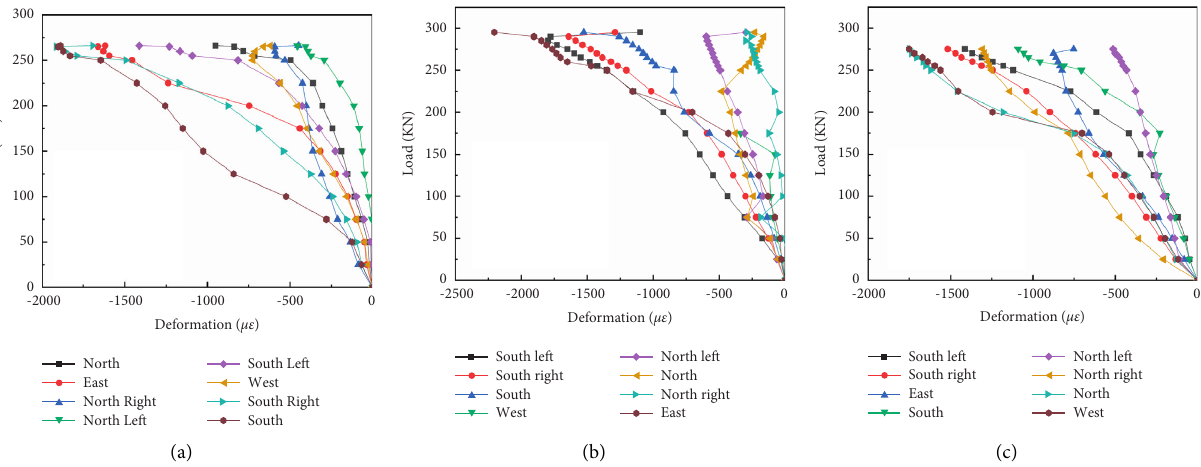
Figure 39: 4C series load-strain curves: (a) 4C-1, (b) 4C-2, and (c) 4C-3.